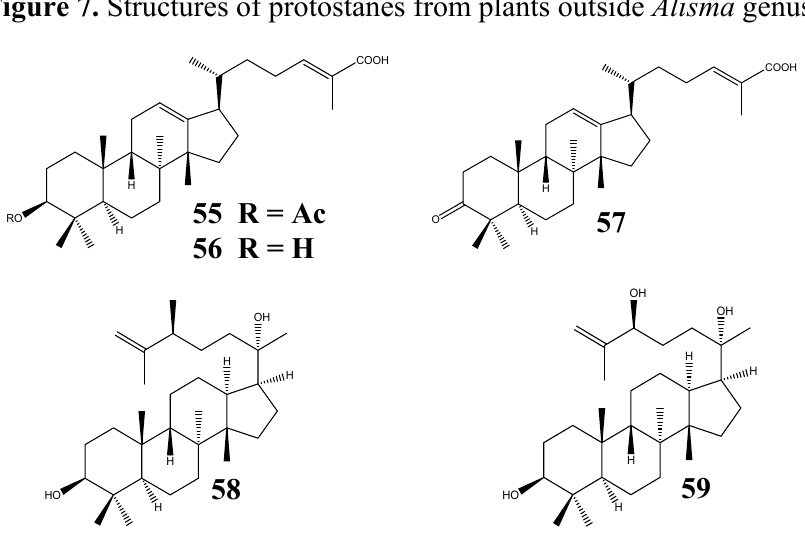
Figure 7. Structures of protostanes from plants outside Alisma